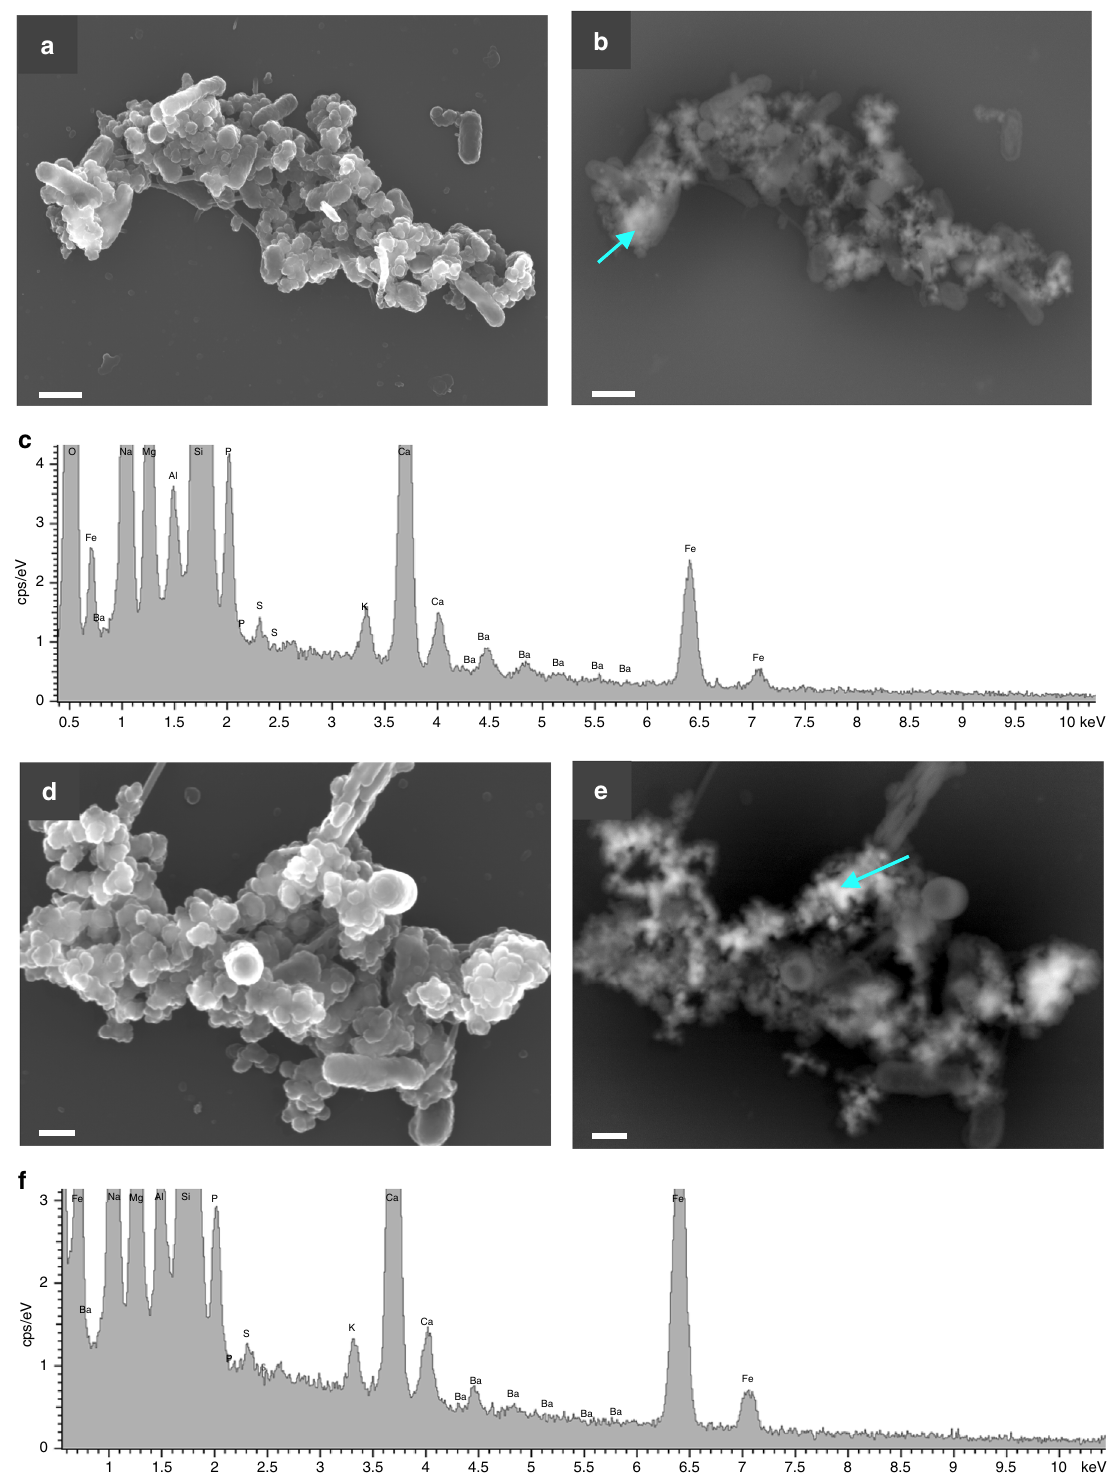
Fig. 2 SEM images of M . hydrocarbonoclasticus and P . okeanokoites bacteria. a , b Photographs of M . hydrocarbonoclasticus obtained by the Inlens detector and backscattered electron mode, respectively. Scale bar represents 1 μ m. c Representative SEM-EDX spectrum. Incubation time was 48 h and the medium SSW2. The corresponding spectrum also shows the composition of the Ba-rich aggregates. d , e Photograph of P . okeanokoites after 96 h of incubation in SSW2 medium obtained under the same microscopy conditions. Scale bar represents 200 nm. f Composition of the precipitates shown in d and e